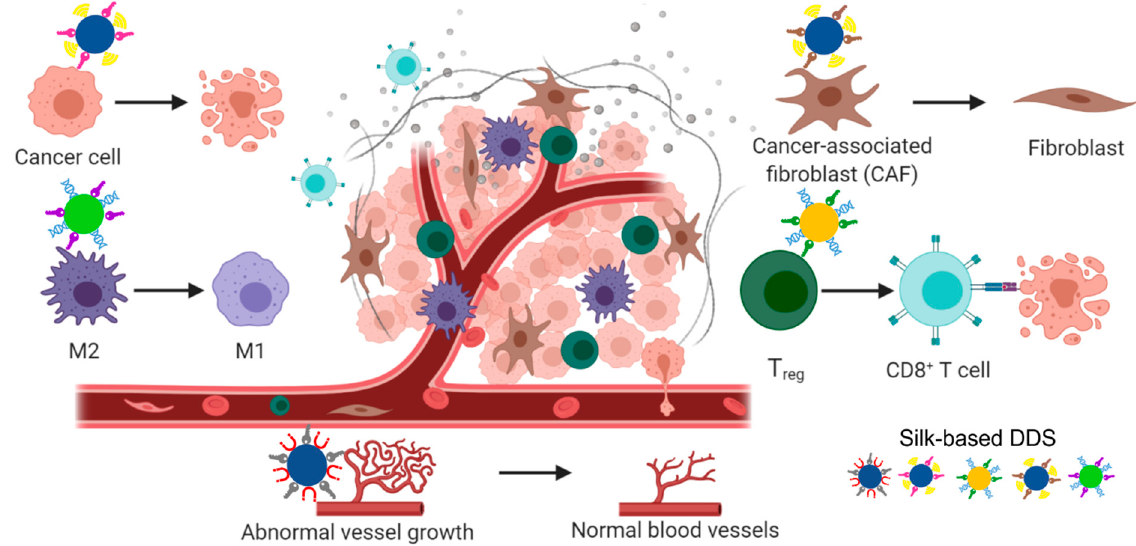
Figure 5. Tumor microenvironment (TME) and potential targets for anticancer therapy. Cancer cells, cancer-associated fibroblasts (CAFs), angiogenesis-related cells (endothelial cells, pericytes), and immunological cells, including tumor-associated macrophages (TAMs/M2) and lymphocytes T reg as potential targets for treatment using silk-based drug delivery system. Created with BioRender.com accessed on 29 June 2021.